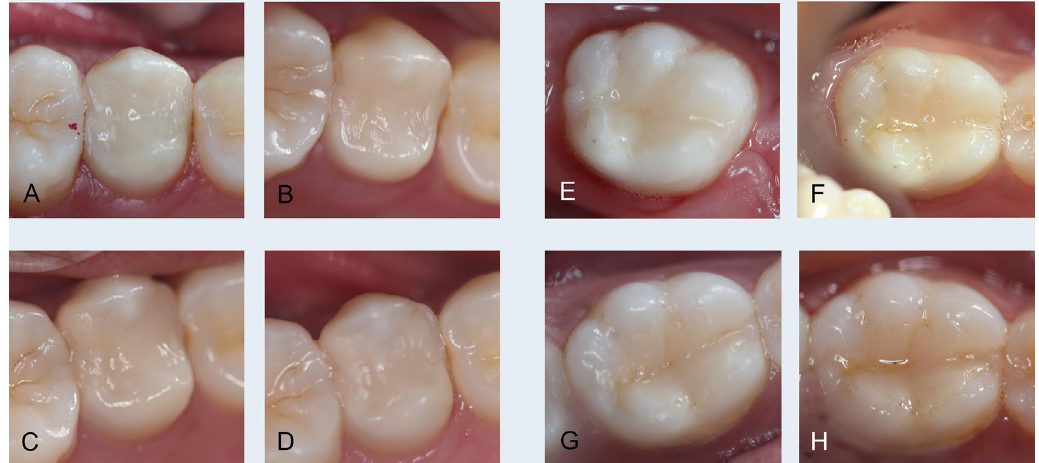
Figure 3- Class II (DO) ART restoration with HVGIC in the upper left second premolar: A) Baseline; B) 6 months; C) 1 year and D) 2 years and Conventional Class II (MO) restoration with resin composite in mandibular right first molar: E) Baseline; F) 6 months; G) 1 year and H) 2